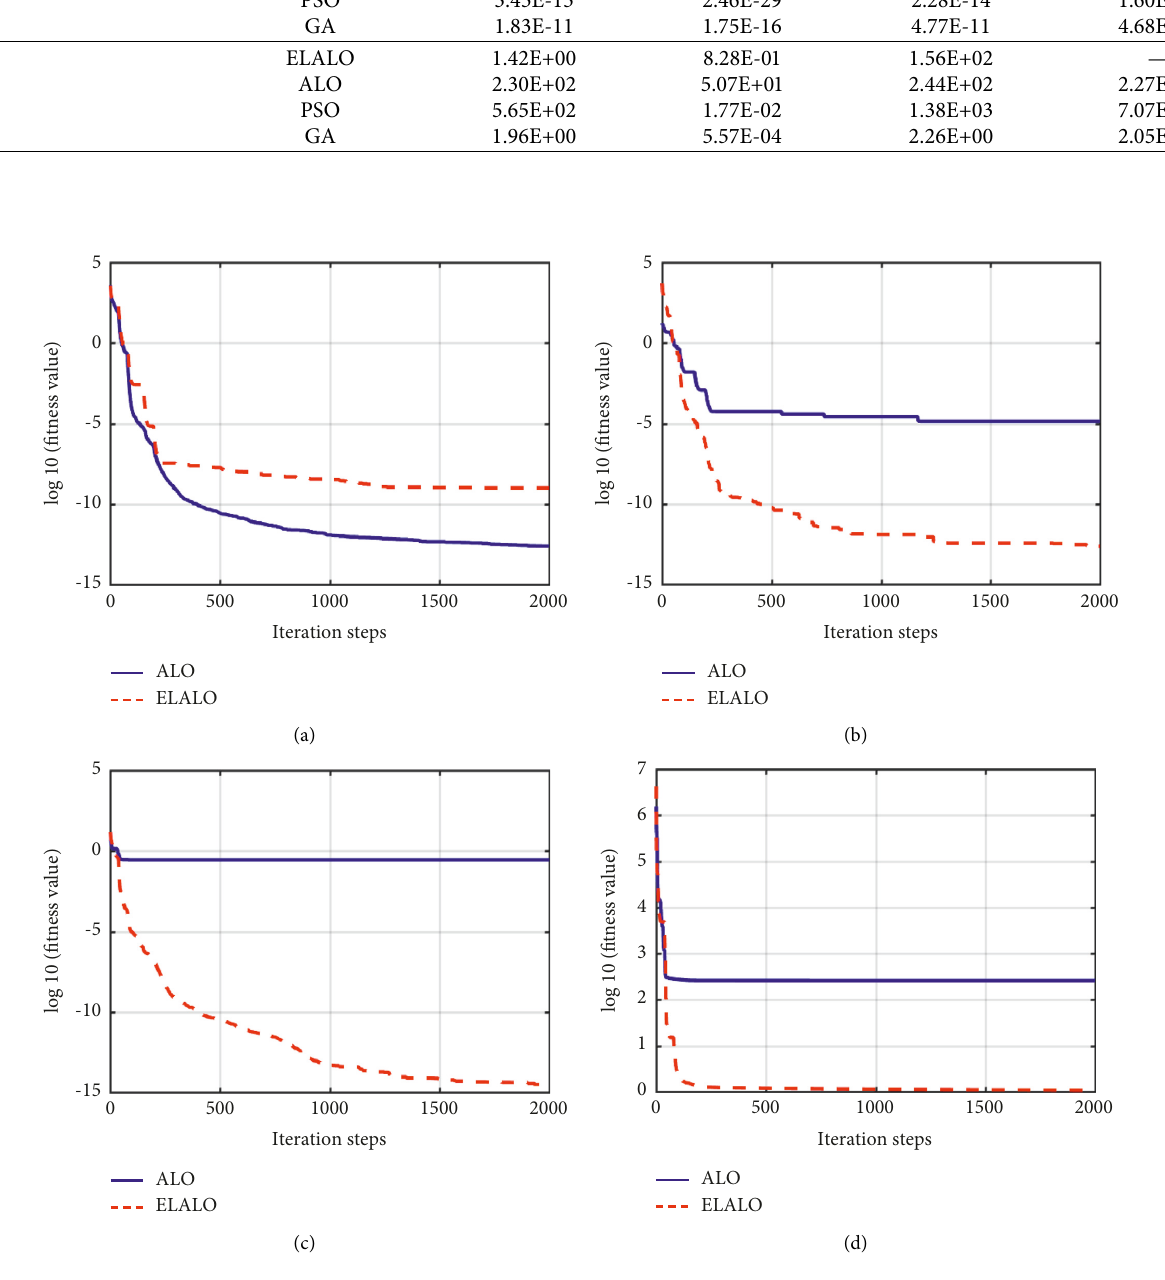
1 , (b) curve comparison on F 2 , (c) curve comparison on F 3 , and